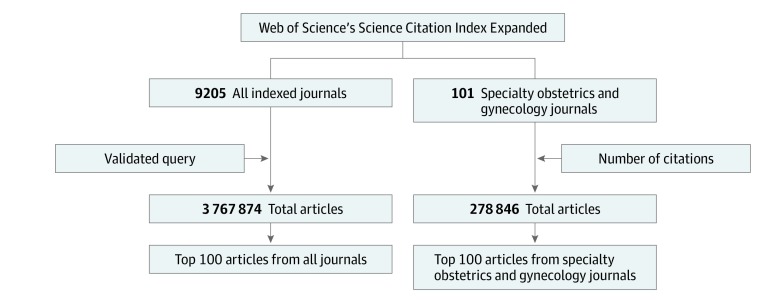
Study Flow Diagram